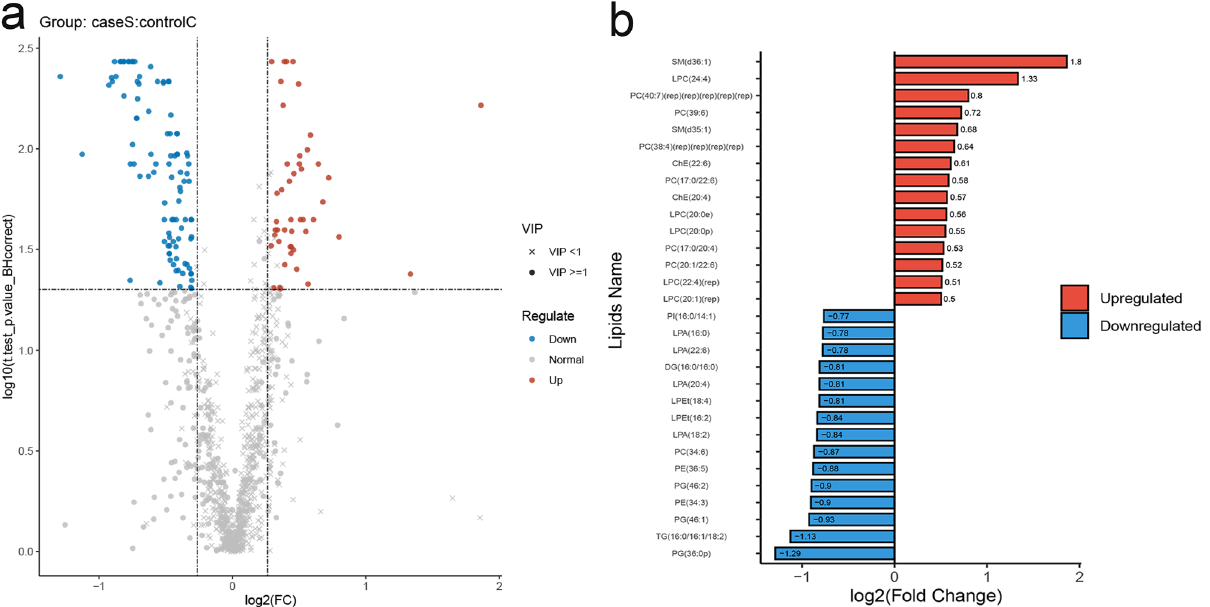
Figure 2. Screening of differential metabolites. ( a ) Volcano plot shows the number of dysregulated lipids in the SCH group compared to the control group. ( b ) Potential biomarkers. Note: (rep) indicates we repeated the identification results of this